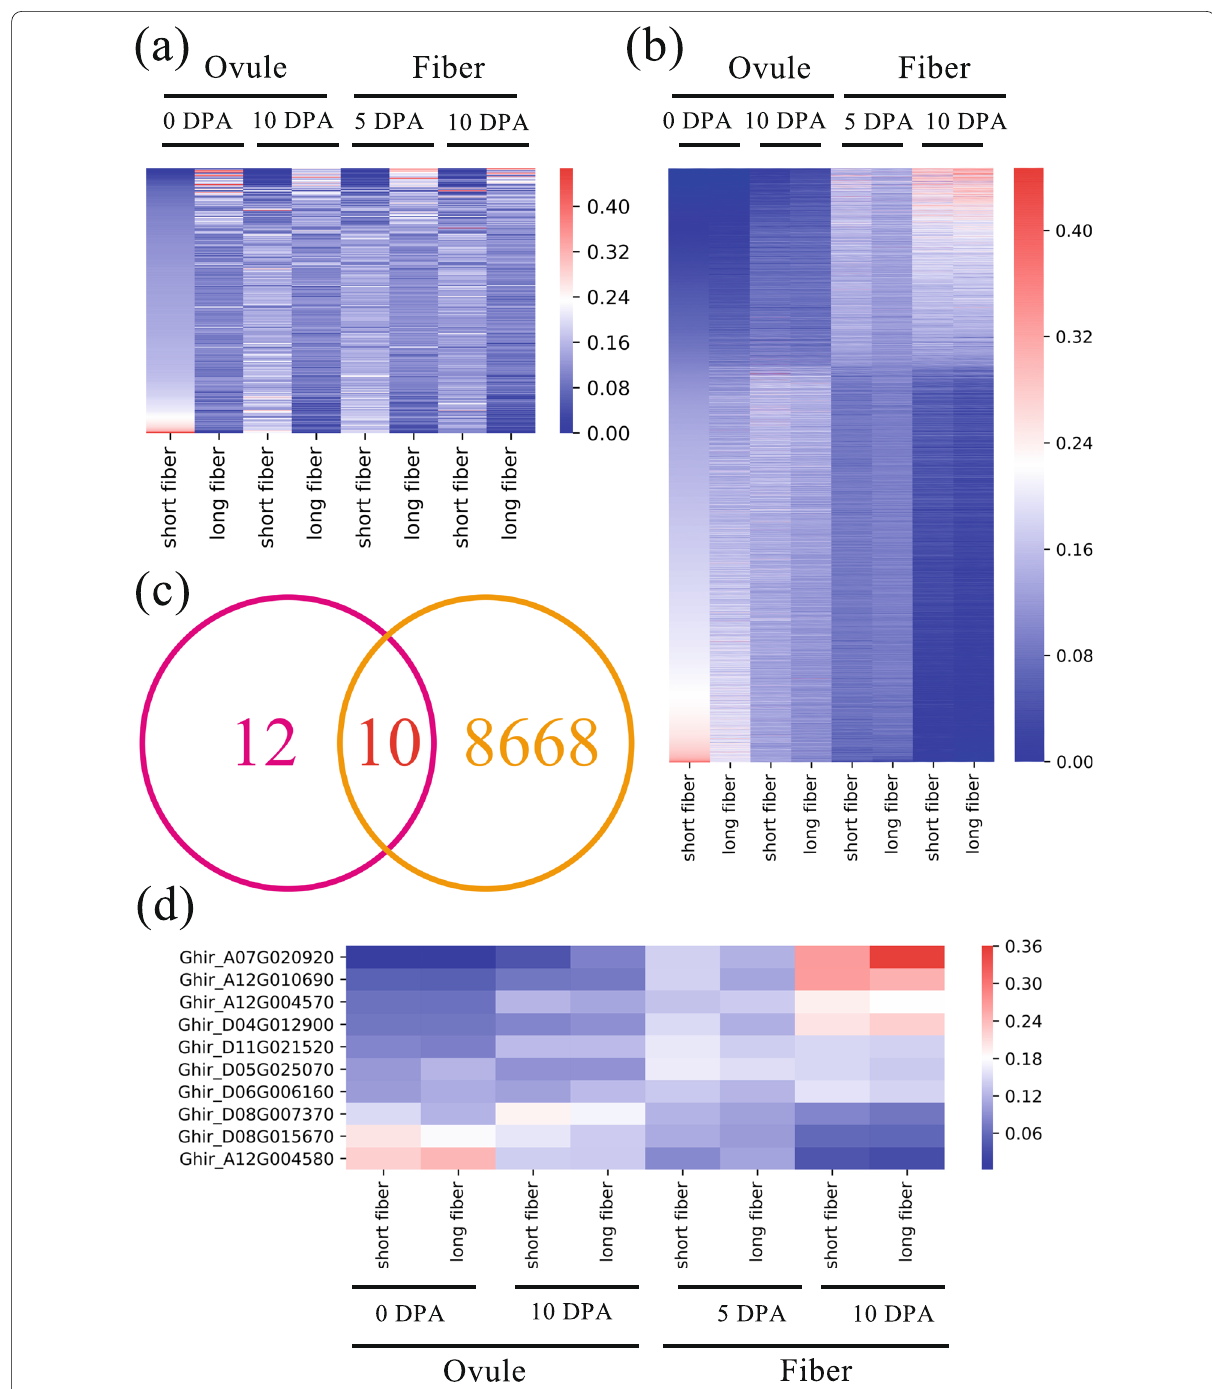
Fig. 4 Characterization of DEGs in transcriptome data. a relative transcription abundance of DEGs among long fiber and short fiber cultivars. b relative transcription abundance of DEGs among fiber and ovule tissues. c Venn plot of 22 Rho members which detected by the combination of transcriptome and association analysis (in magenta color) and DEGs in fiber/ovule tissues (in orange colors). d differentially expressed Rho genes between fibers and ovules (overlapped genes in c